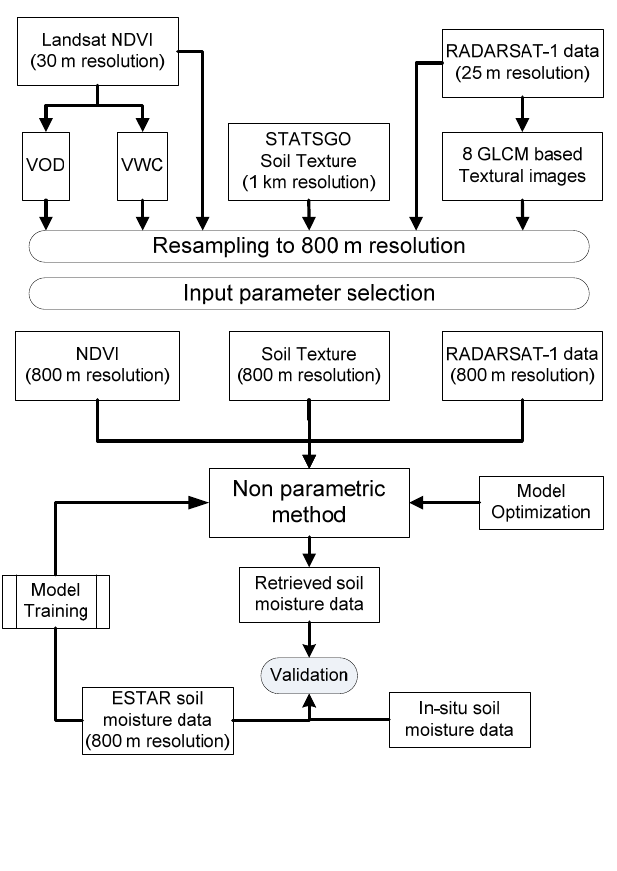
Figure 3. Flow chart of steps performed for soil moisture retrieval using non parametric